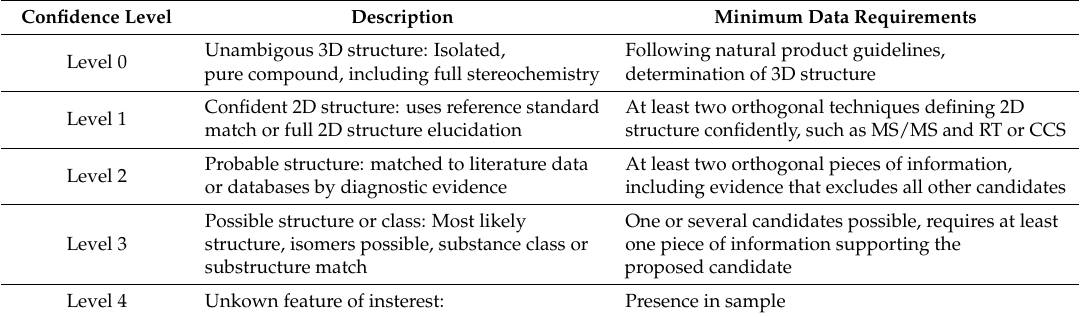
Table 1. New confidence levels of compound annotations, as discussed by the Compound Identification work group of the Metabolomics Society at the 2017 annual meeting of the Metabolomics Society (Brisbane, Australia). The new addition refers to the ‘Level 0’ annotation; other levels remain as discussed by the Metabolomics Standards Initiative.